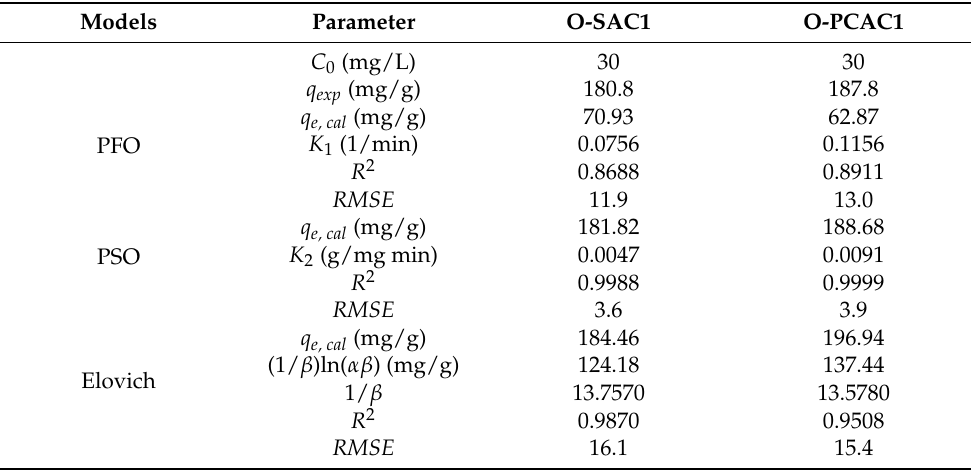
Table 4. Kinetics parameters of NAP adsorption onto IMACs at 303 K.